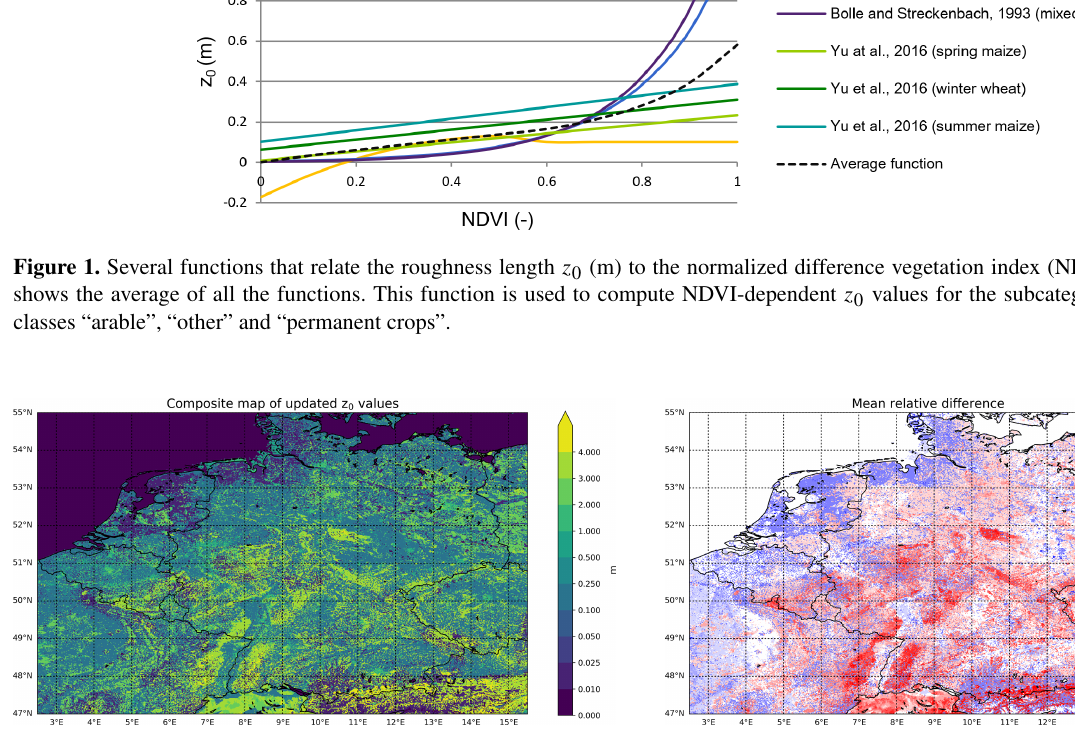
Figure 2. Composite map of the new z 0 values. The yearly mean is displayed for land use classes with time-variant z 0 values.